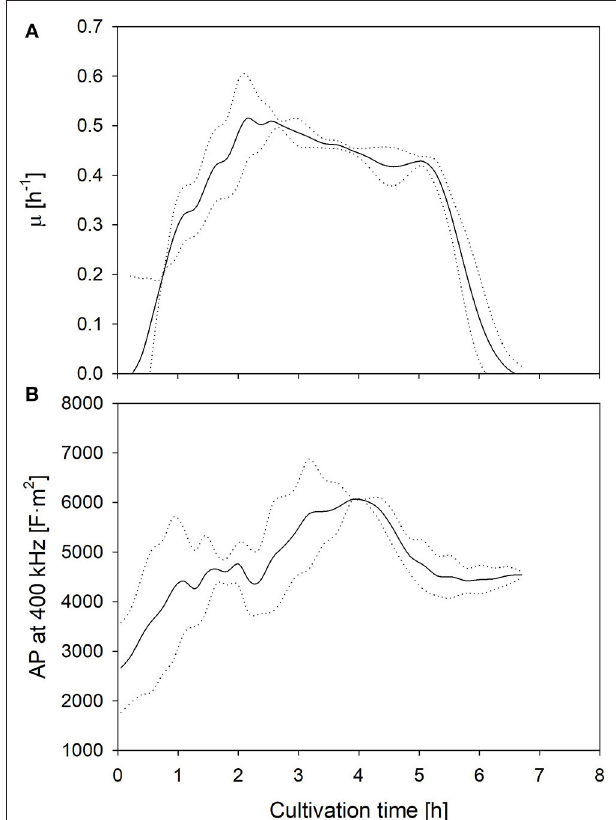
FIGURE 1 | Mean growth rate (A) as well as AP level at 400kHz (B) development during fermentations under optimum (standard) conditions. Dotted lines represent the limits of the standard deviations between two biological